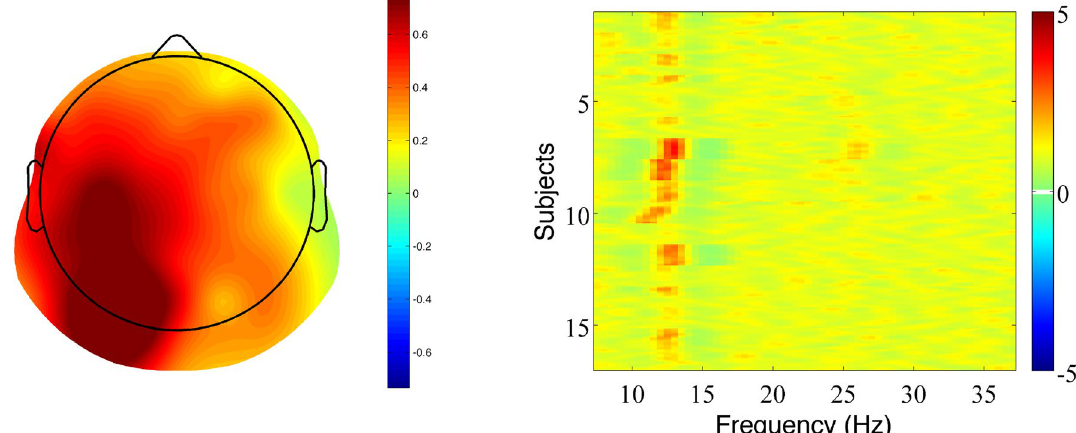
Figure 6. Rhythmic entrainment source separation (RESS) filtered power spectra optimized for 12.50 Hz (Suffix). Left panel: Topographic map, averaged across participants. Topoplot color was normalized to [− 1 1] to facilitate visual comparison. Right panel: Spectral density (SNR) between 5 and 37 Hz for each participant (rows). The vertical red line at 12.50 Hz corresponds to the entrainment at the stimulation frequency. Alpha activity is not visible in the right panel, likely for two reasons. First, the SSVEPs are calculated as SNR (i.e., the difference between power at the stimulation frequency and power at the average of neighbouring